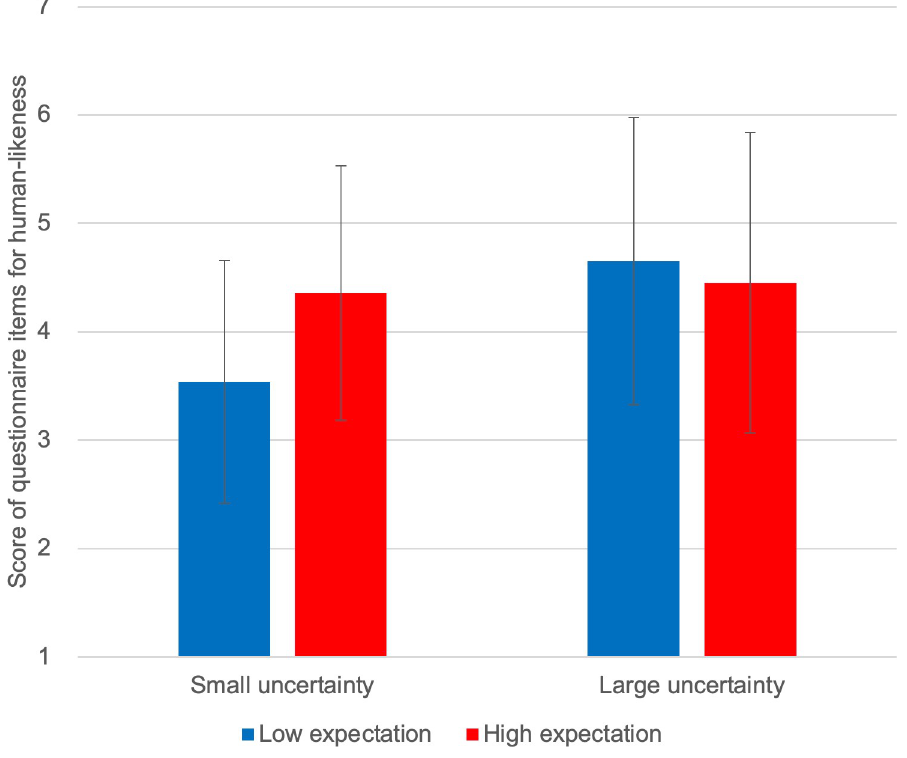
Fig 10. Self-reported